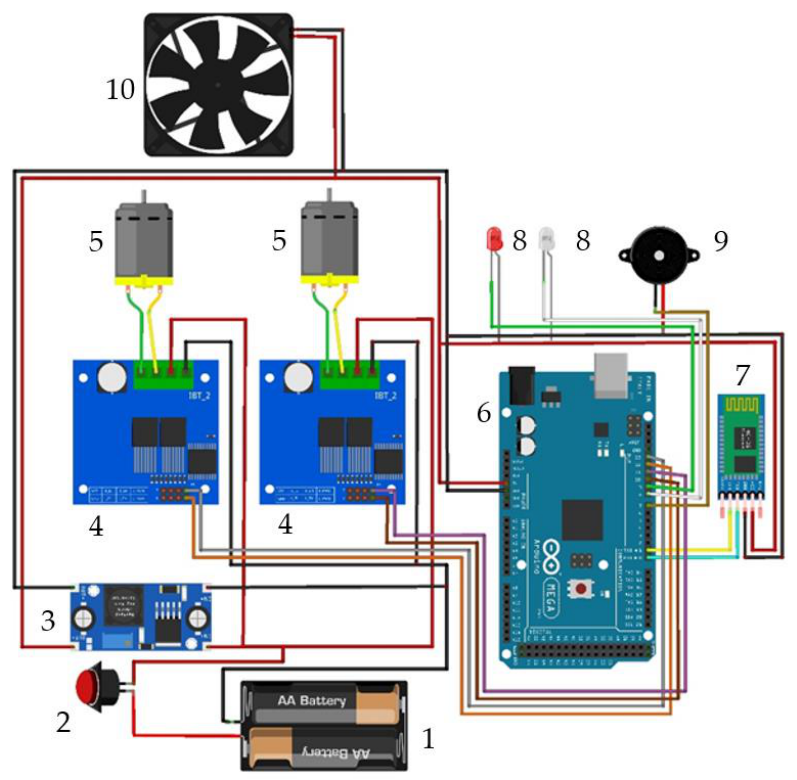
Figure 9. Control circuit diagram for the robotic vehicle (1 — batteries, 2 — on/off button, 3 — LM2596 step-down converter, 4 — BTS7960B module controls for motors, 5 — electromotors, 6 — Arduino MEGA, 7 — Bluetooth module HC-06, 8 — LEDs. 9 — buzzer, 10 — fan).